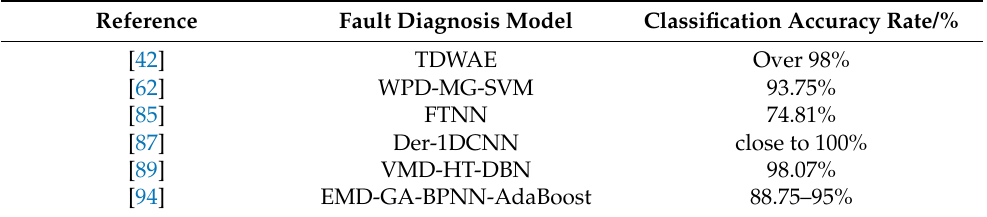
Table 2. Partial models and accuracy of fault diagnosis for the rolling bearing of railway